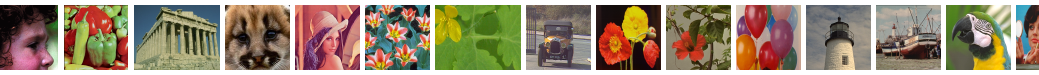
Figure 6. Test images for image super-resolution performance evaluation